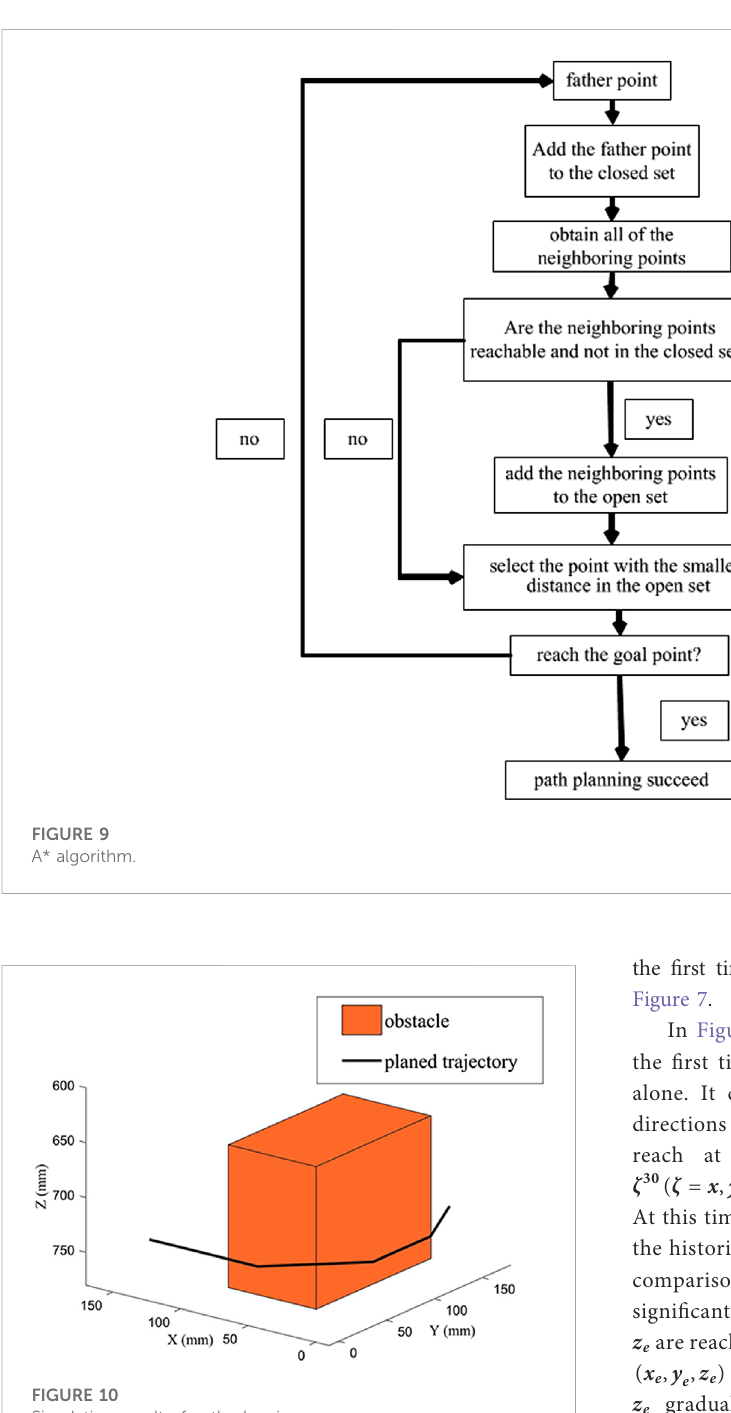
FIGURE 10 Simulation result of path